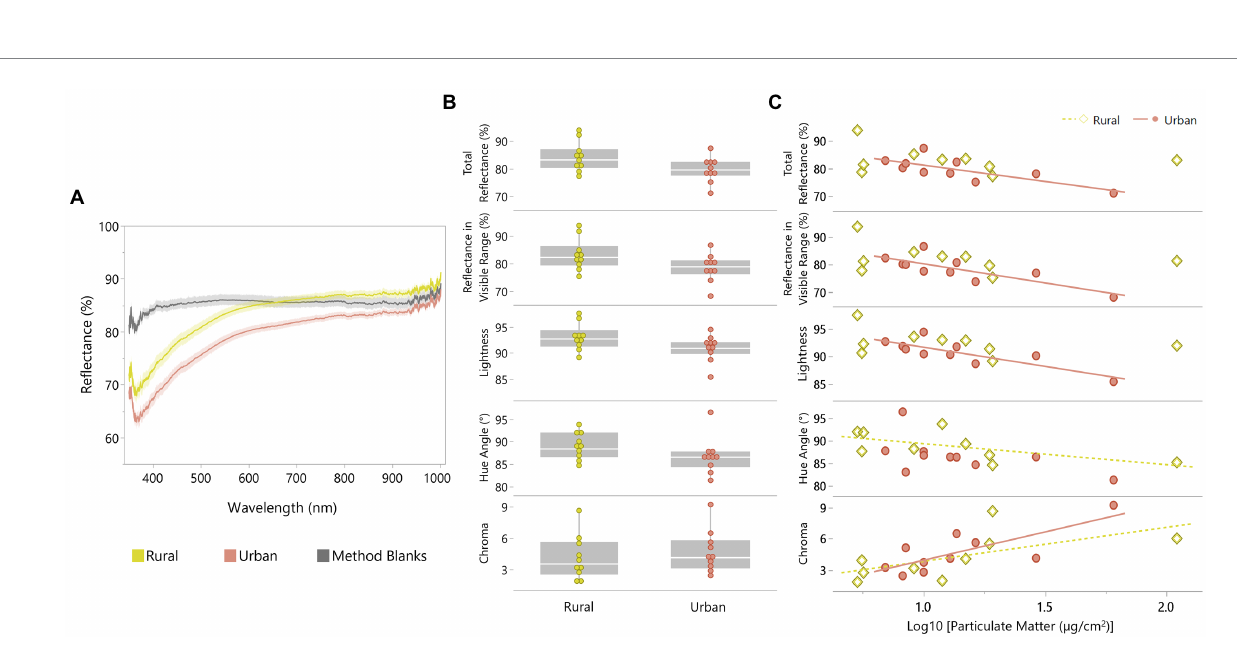
FIGURE 4 (A) Reflectance spectra of particulate matter (PM) accumulated on glass microfiber filters for rural and urban pigeon populations compared to spectra of control filters. Spectra are smoothed using a Savitzky–Golay filter with a 3rd order polynomial fit. Shaded areas represent a 90% CI. (B) Box plots of spectral properties - total reflectance (350–1,000 nm), reflectance in the visible range (400–779 nm), lightness, hue angle, and chroma for PM from feathers of rural and urban pigeon populations. (C) Relationships between PM accumulation and total reflectance (350–1,000 nm), reflectance in the visible range (400– 779 nm), lightness, hue angle, and